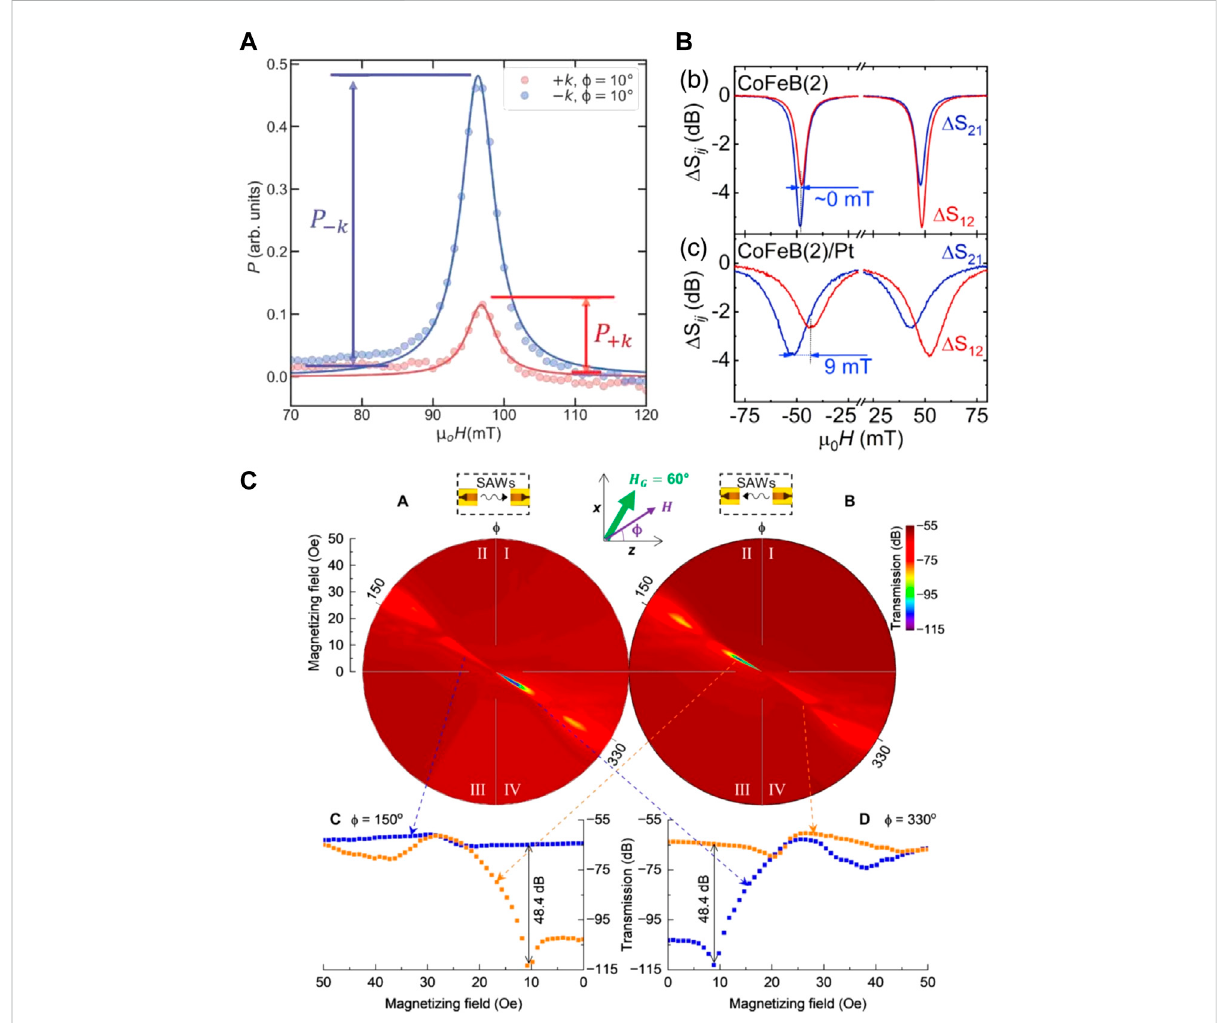
FIGURE 2 Experimentalresults ofnonreciprocalmagnetoacousticsurfacewavespropagatingininverteddirections k > 0and k < 0(or+ k and − k ). (A) The SAW-SW helicity mismatch effect in Ta(10 nm)/Co 20 Fe 60 B 20 (1.6 nm)/MgO(2 nm) is enhanced by magneto-rotation coupling and causes at 6.1 GHz and ϕ H = 10 ° a pronounced nonreciprocity of the absorbed power P ± k . (B) The resonance fi elds are solely nonreciprocally shifted for Co 40 Fe 40 B 20 (2 nm)/Pt (3 nm), but not for Co 40 Fe 40 B 20 (2 nm), since interfacial DMI is mediated by the Pt layer. The background corrected SAW transmission Δ S 21,12 for counter-propagating SAWs with k < 0 and k > 0 was measured at 6.9 GHz and ϕ H = 64.8 ° . Adapted from reference [30]. (C) The magnetic dipolar fi elds of the SW cause nonreciprocally shifted resonance fi elds in the magnetic bilayer FeGaB(20 nm)/Al 2 O 3 (5 nm)/ FeGaB(20 nm) at 1.4 GHz. The upper two panels show the SAW transmission as a function of the external magnetic fi eld magnitude H and orientation ϕ H for counter-propagating waves. The two diagrams below depict line cuts at ϕ H = 150, 330 ° for k > 0 (blue) and k < 0 (orange). (A,C) From [29, 72]. ⓒ The Authors, some rights reserved; exclusive licensee AAAS. Distributed under a CC BY-NC 4.0 license “ http://creativecommons.org/licenses/by-nc/4.0/ ” . Reprinted with permission from